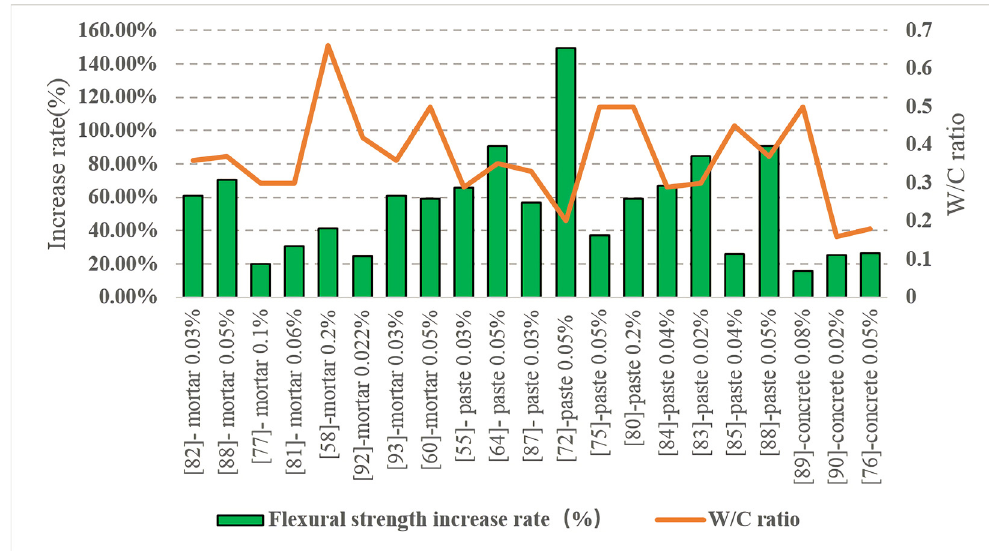
Figure 11: Flexural strength enhancement of GO reinforced cement composite